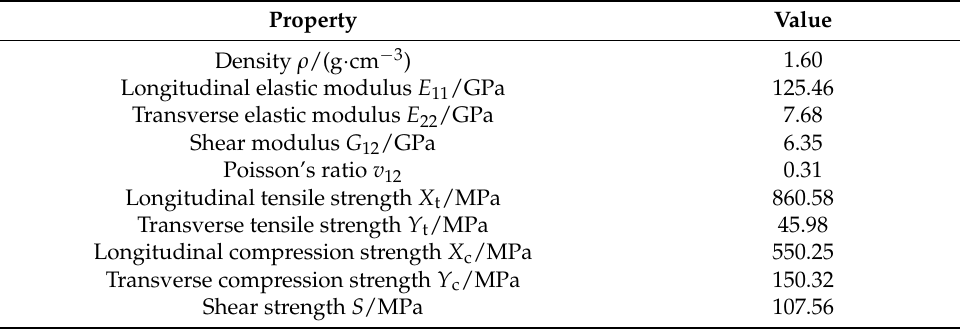
Figure 2. Mechanical tests of CFRP: ( a ) tensile specimens; ( b ) tensile test; ( c ) compression test. Table 3. Mechanical parameters of CFRP.